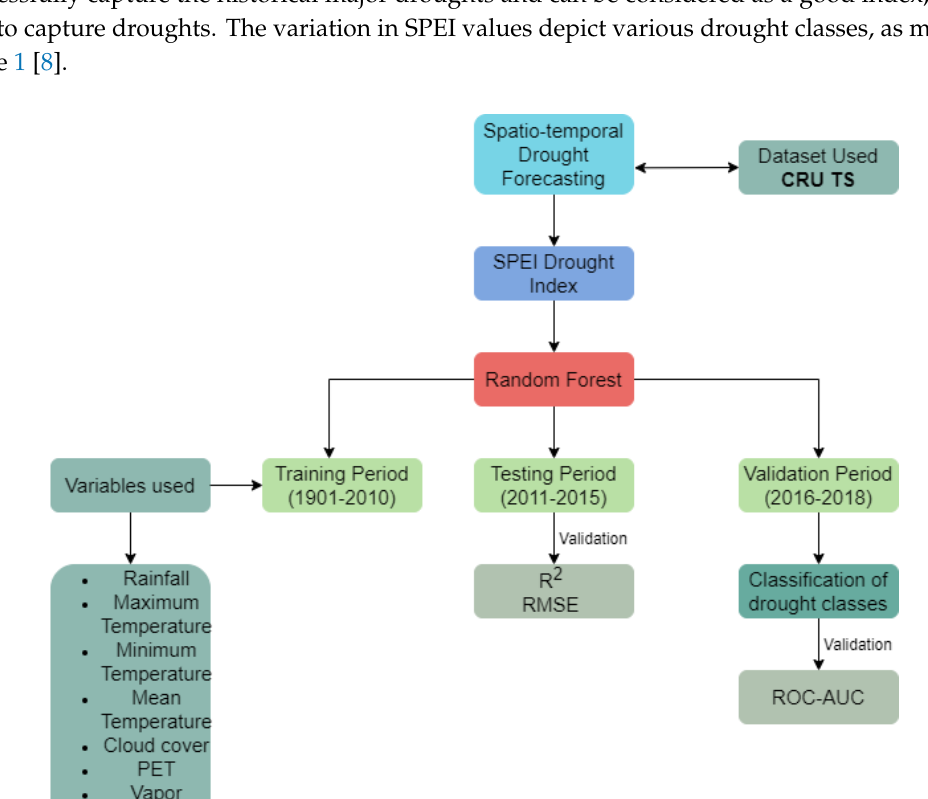
Figure 5. SPEI variation for two major droughts, ( a ) 1937–1945 (World War II Drought) and ( b ) 2001– 2010 (Millennium Drought). 3.2. Random Forests and Performance Analysis The study of drought forecasting has seen the use of various ML-based models; however, the present study focusses only on Random Forest (RF), as its performance is similar to other supervised learning models, such as support vector machine or boosted regression trees [9,47]. However, the RF- model has been comparatively less tested, especially in Australia. Previous studies have used remote- sensing-based data to forecast drought, using neural networks and RF [48] for wheat belts in the region. The present study forecasts the drought index, using a climatological dataset for the entire NSW region, and is the first study of its kind. The RF model was proposed by Reference [49], an